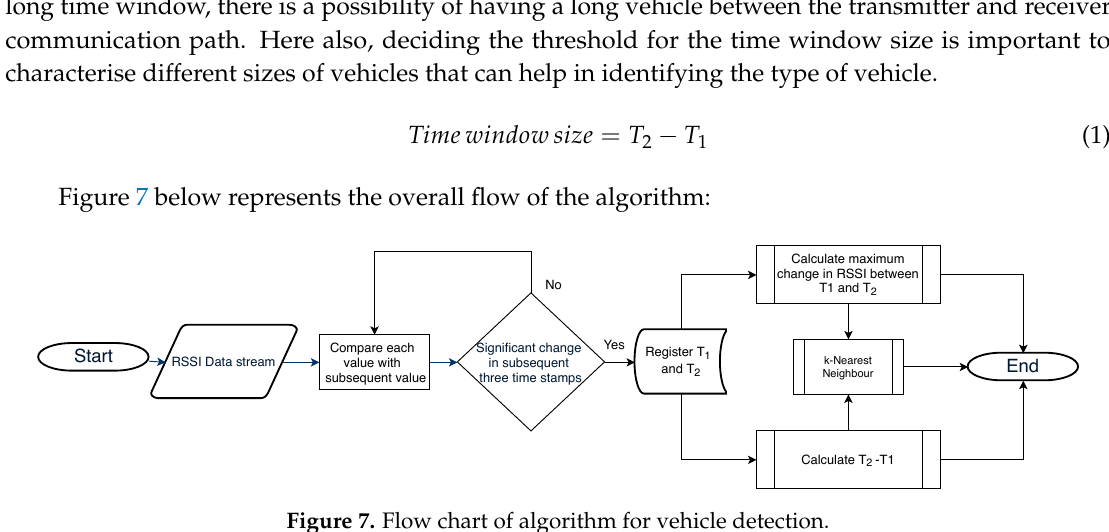
Figure 7. Flow chart of algorithm for vehicle